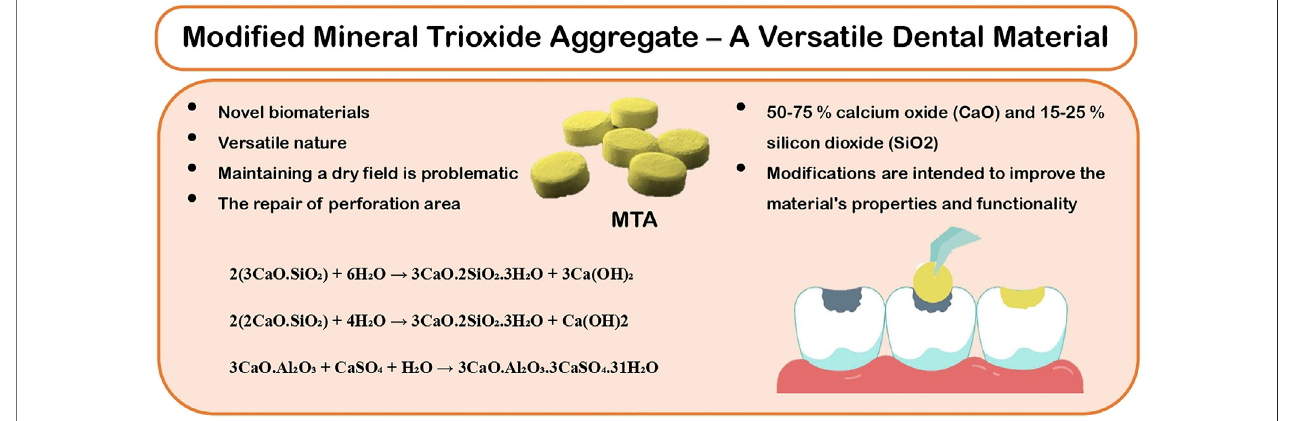
FIGURE 1 | Properties that make modi fi ed MTA a versatile dental